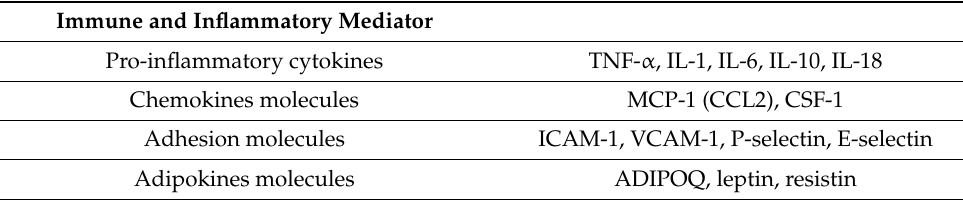
Table 2. Inflammatory and immune mediators implicated in DKD. Immune and Inflammatory